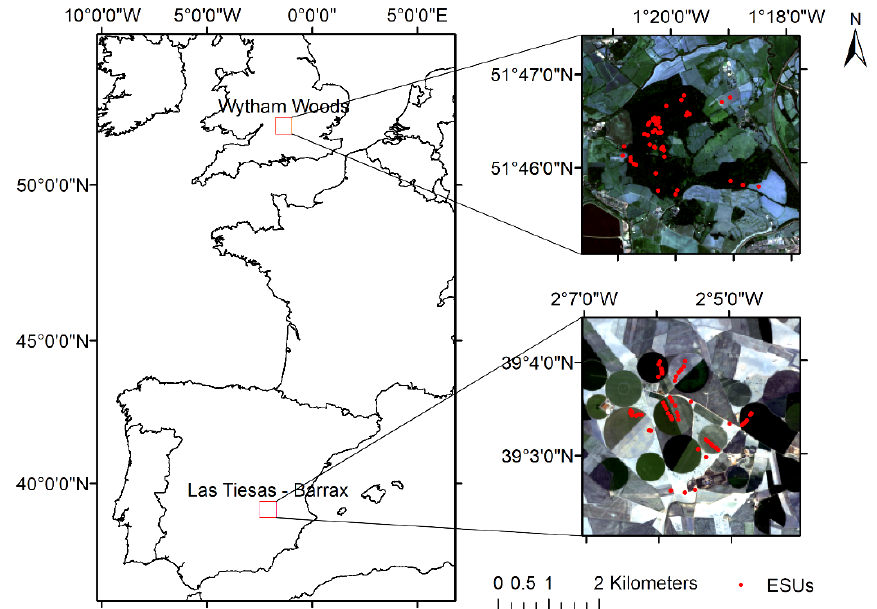
Figure 2. Location of the Las Tiesas–Barrax and Wytham Woods study sites ( left ), and Sentinel-2 MSI true-colour composites over a 5 km × 5 km area acquired on 13 June and 6 July 2018, respectively ( right ). Red dots indicate the location of sampled ESUs.